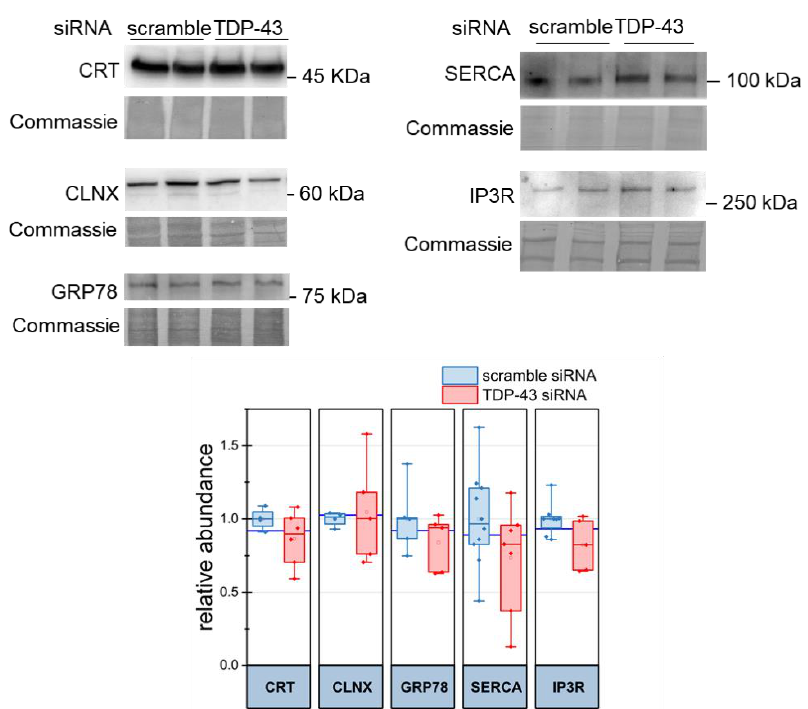
Figure 3. TDP-43 silencing does not modify the expression of proteins involved in ER Ca 2+ home- ostasis. The abundance of CRT, CLNX, GRP78, IP3R or SERCA was monitored by WB in both control (scramble) and TDP-43-silenced HeLa cells. The upper panel shows a representative WB for each analysed protein and the corresponding Coomassie blue staining of the membranes; the box plot in the lower panel reports the relative abundance (normalised to control samples) of each protein. n = 5, p -value > 0.999 (Mann–Whitney U test).